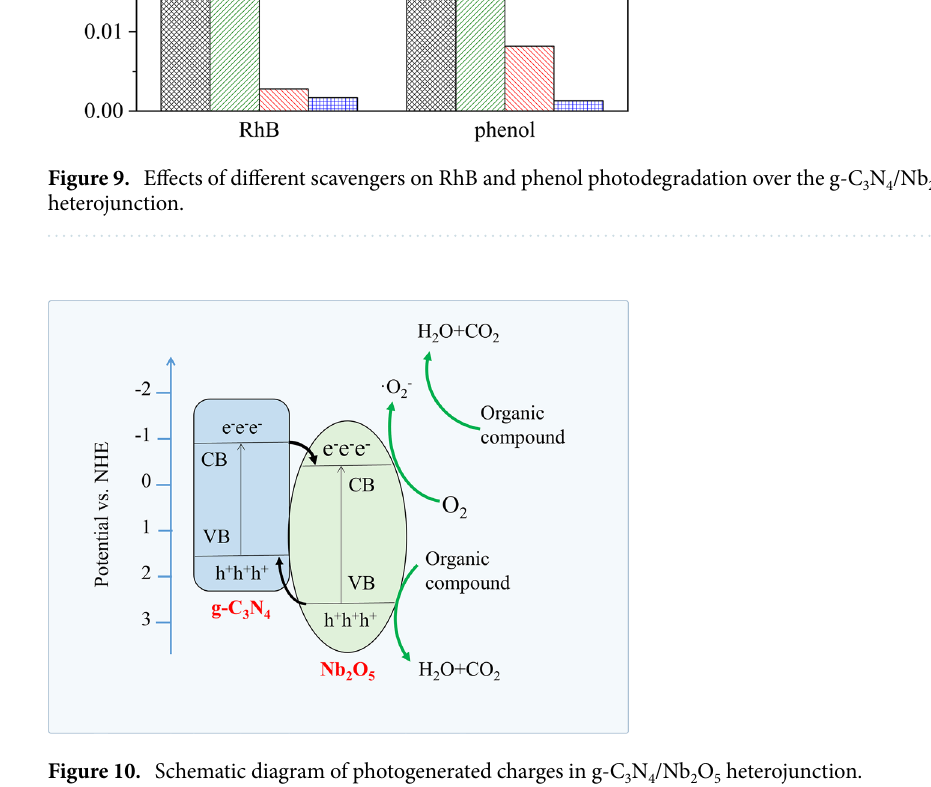
Figure 10. Schematic diagram of photogenerated charges in g-C 3 N 4 /Nb 2 O 5